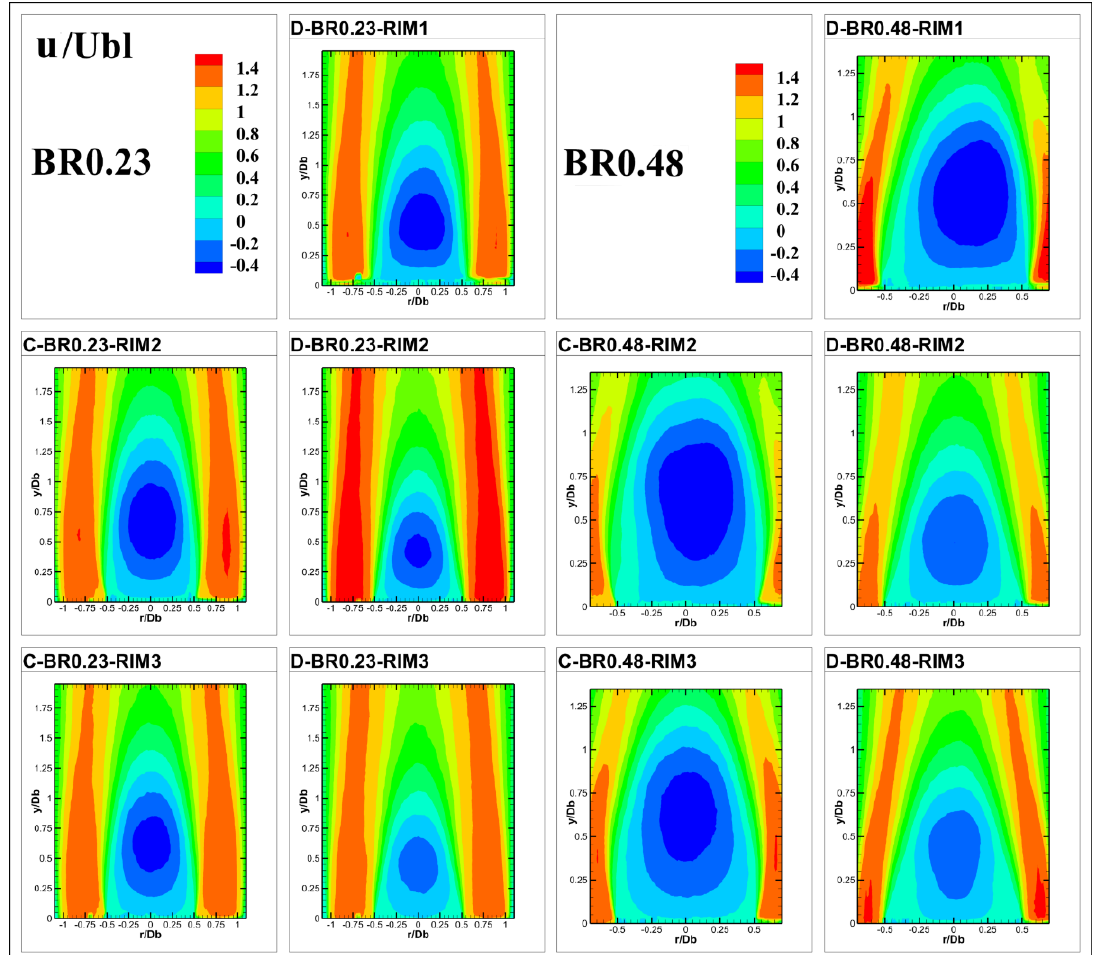
Figure 3. Normalized time averaged axial velocity field.